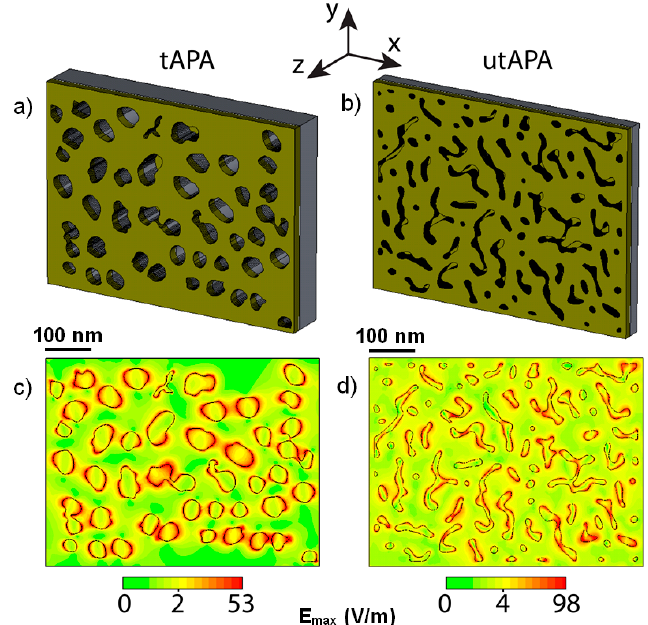
Figure 4. Simulations of the electric field intensities on the APA-Au nanostructures in the cases of the respective maxima, both occurring close above the bottom Au layer inside the pores: ( a , c ) tAPA (80-nm APA thickness, 25-nm Au thickness, vertical position from bottom z = 30 nm, E max = 58); ( b , d ) utAPA (30-nm APA thickness, 20-nm Au thickness, vertical position from bottom z = 20 nm, E max = 163).